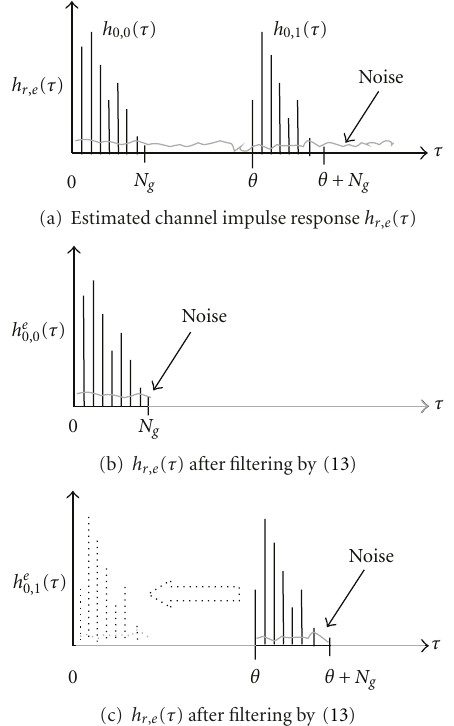
Figure 4: Estimation of the channel impulse responses ( h e 0,0 and h e 0,1 between the relay and the first and second user during the first transmission